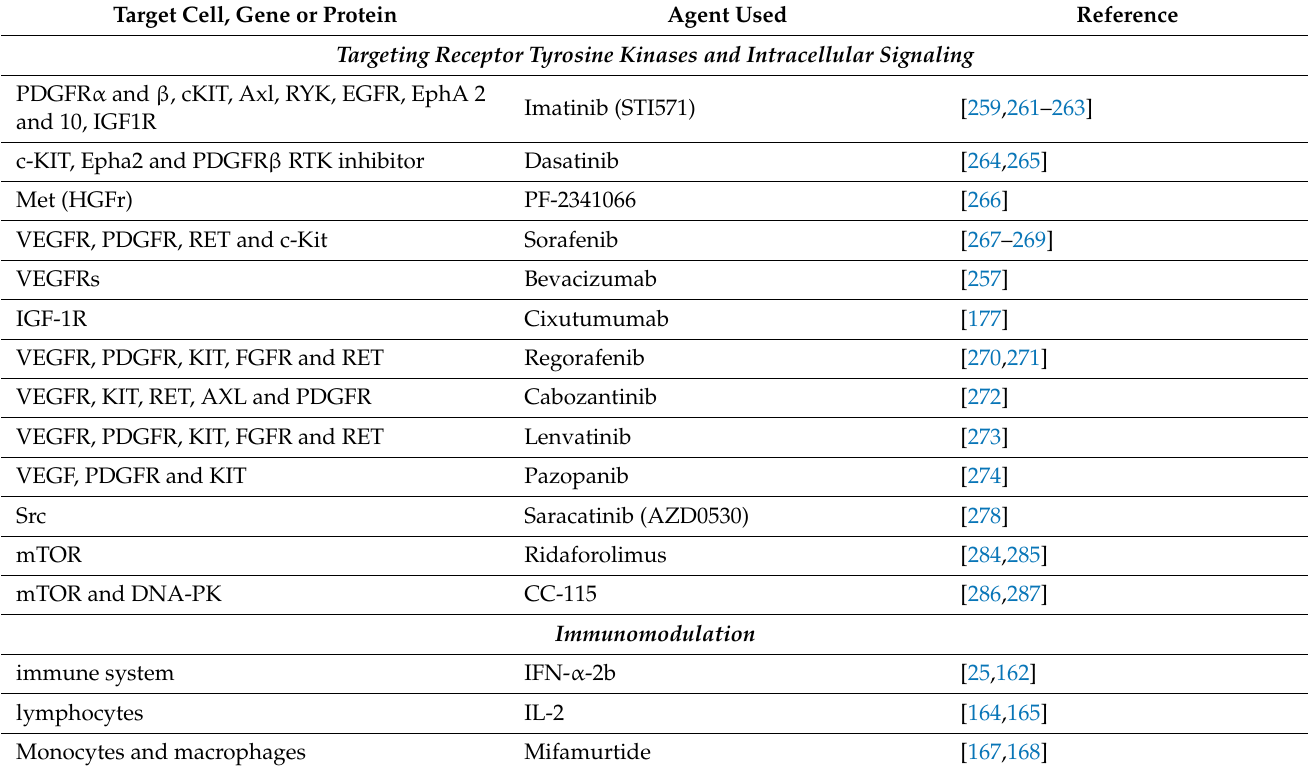
Table 4. New therapeutic approaches in